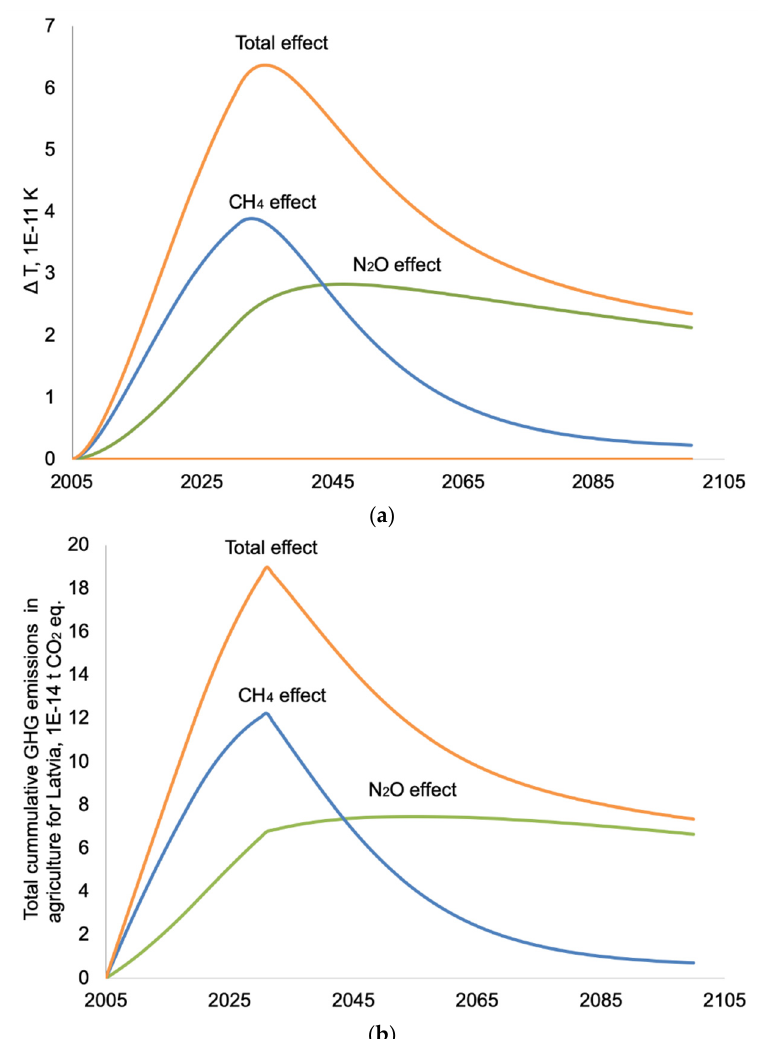
Figure 14. ( a ) Absolute global temperature change potential (AGTP) and ( b ) global temperature change potential (GTP) calculated for the emissions from agriculture in Latvia.